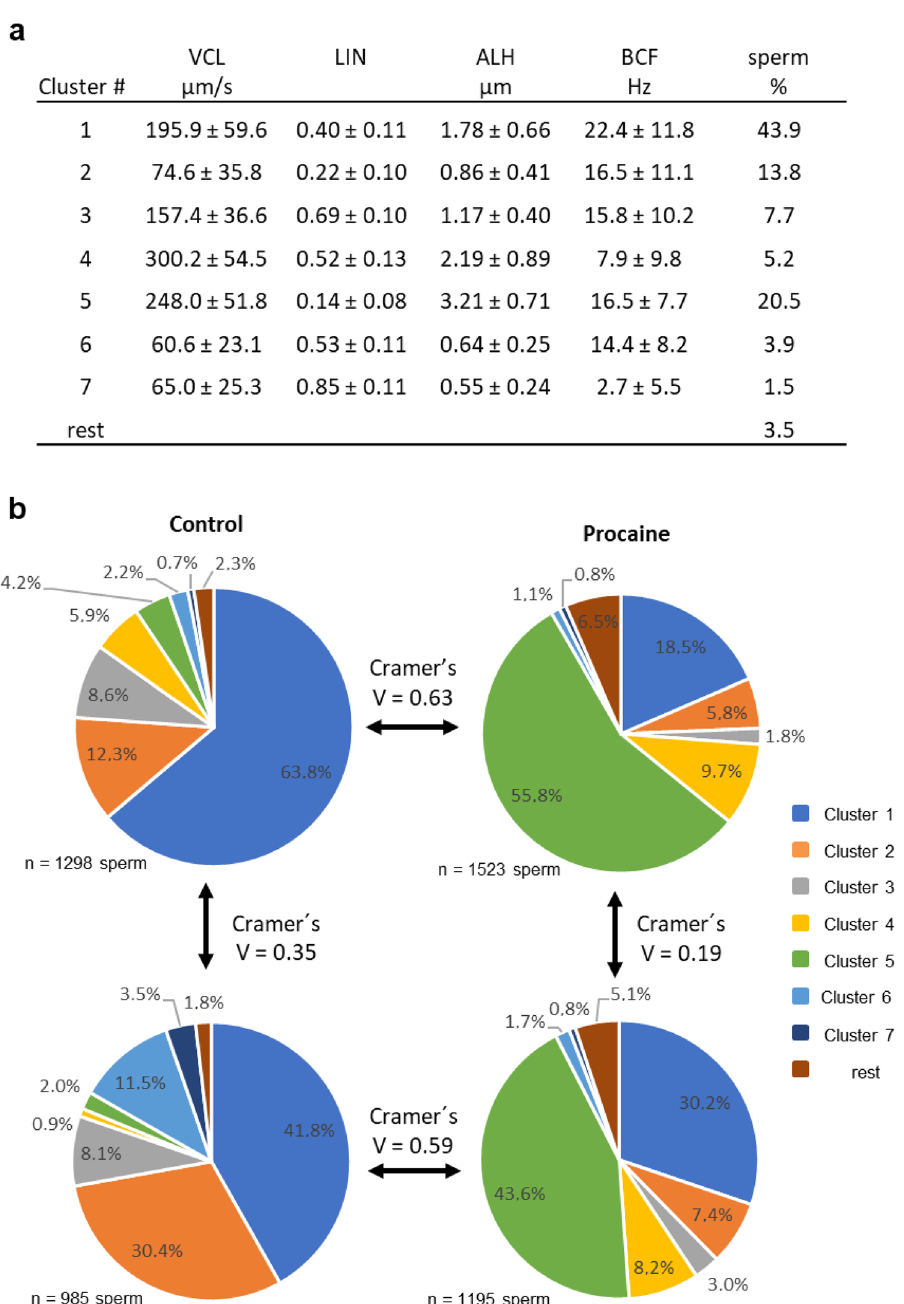
Figure 4. Motility patterns of morphologically normal spermatozoa originating from extended semen samples with either enhanced (≥ 15% = high MAS; n = 10 boars) or low (< 5% = low MAS; n = 9 boars) prevalence of sperm with cytoplasmic droplets and/or bent tails in the absence or presence of procaine. Extended semen samples were centrifuged, and pelleted sperm incubated in non-capacitating Tyrode’s medium without (control) or with 7.3 mM procaine for 10 min at 38 °C. ( a ) Motility characteristics of sperm from the different clusters. Only clusters containing at least 5% of sperm in any of the sperm subsets from this experiment were considered for evaluation. ( b ) Effect of procaine on motility patterns of sperm with normal morphology from samples with low MAS (upper pie charts) or high MAS (lower pie charts). Cramer’s V (range from 0 to 1) indicates the effect size of sample origin or procaine treatment on sperm distribution to the different cluster (movement patterns). V < 0.1 = no effect; 0.1 ≤ V < 0.3 small effect; 0.3 ≤ V < 0.5 moderate effect; V ≥ 0.5 = large